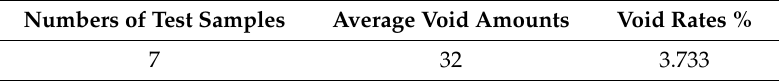
Figure 10. Statistical curve-fitting of void size and location distributions in solder joints of samples a22–a28: ( a ) lognormal distribution curve fitting of void diameters; ( b ) normal distribution curve fitting of X coordinates of voids; ( c ) normal distribution curve fitting of Y coordinates of voids. Table 10. The measured void information in solder joints (samples a22–a28).